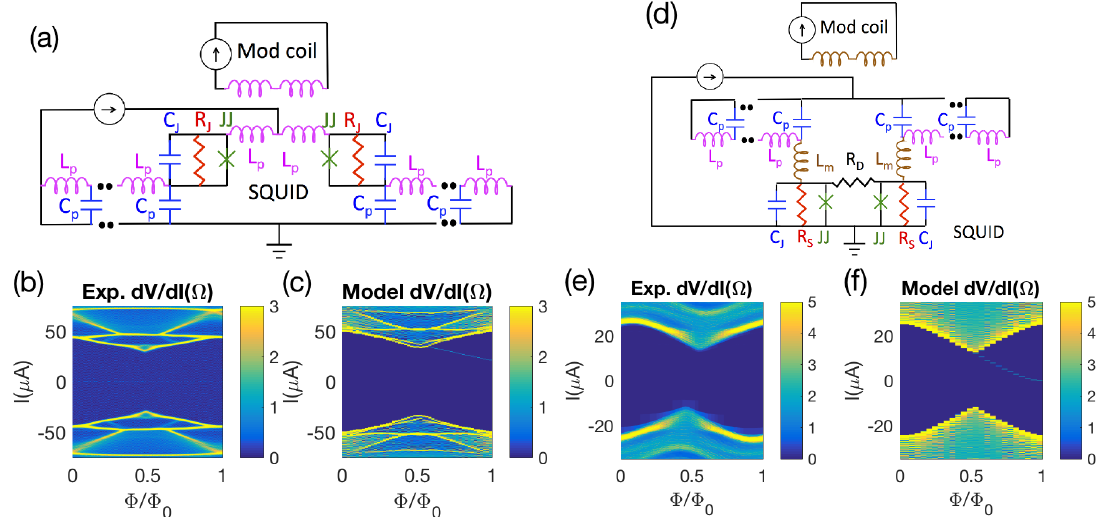
Figure 3. Modeling of dV / dI vs. I and Φ ( IR Φ ) for two types of SQUID susceptometers: ( a ) Undamped schematic, ( b ) experimental dV / dI characteristic, and ( c ) calculated dV / dI characteristic at T = 4.2 K for a SQUID with the layout of Figure 1a [14,15]. In this model, I 0 = 25 µ A, R J = 2 Ω , C J = 10 fF, L m = 30 pH, L p = 4 pH, and C p = 8 pF. There are a total of five L p , C p pairs in each arm to the left and right of the schematic, representing the coaxial leads to the pickup loops. ( d ) Damped schematic, ( e ) experimental dV / dI characteristic, and ( f ) calculated dV / dI characteristic at T = 4.2 K for a SQUID with the layout of Figure 1b [12]. In this model, I 0 = 12 µ A, R J = 2 Ω , R D = 4 Ω , C j = 10 fF, L m = 30 pH, L p = 1 pH, and C p = 8 pF. There are five L p , C p pairs in each arm of the center of the schematic, representing the coaxial leads to the pickup